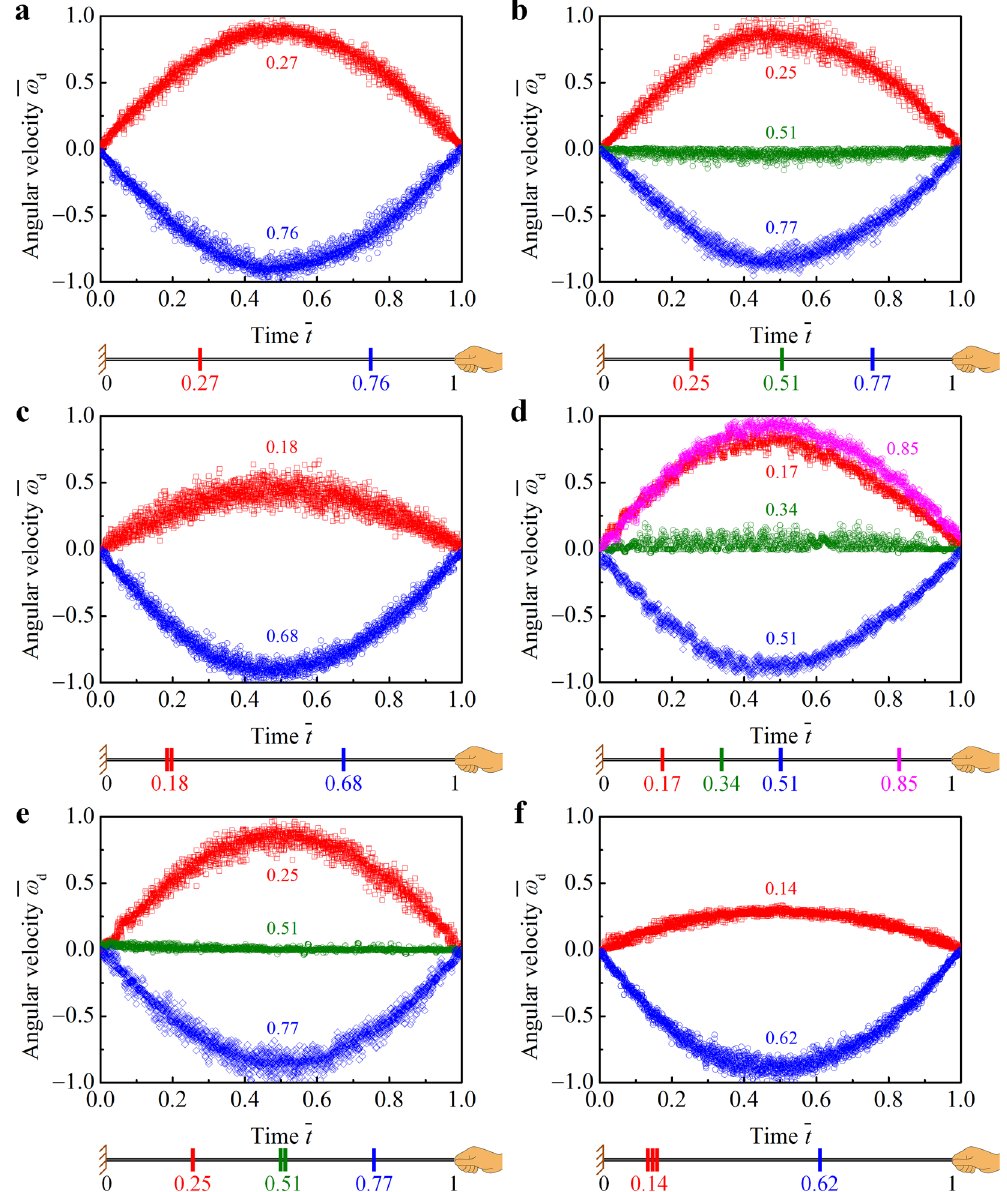
Figure 6. Spinning multiple disks on a string. Temporal evolution of the normalized angular velocity ω disks and their equilibrium positions were measured by using a high-speed camera, with two disks in ( a ), three disks in ( b ) and ( c ), and four disks in ( d )–( f ), respectively. All these drawings were drawn by the first author Zi- Long